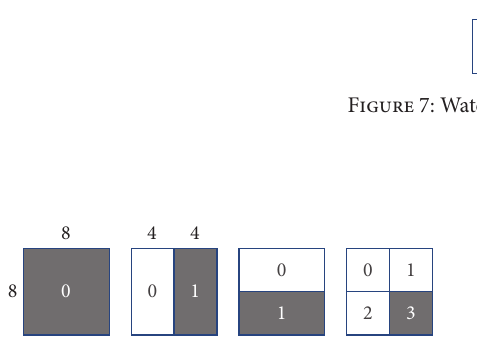
Figure 8: Watermarked macroblock subpartitions: 8 × 8, 4 × 8, 8 × 4, and 4 ×